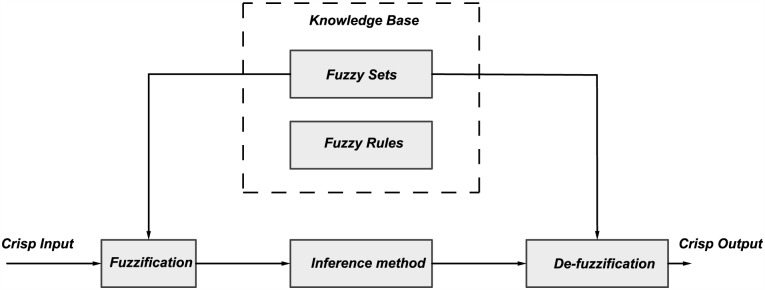
Fuzzy logic system.